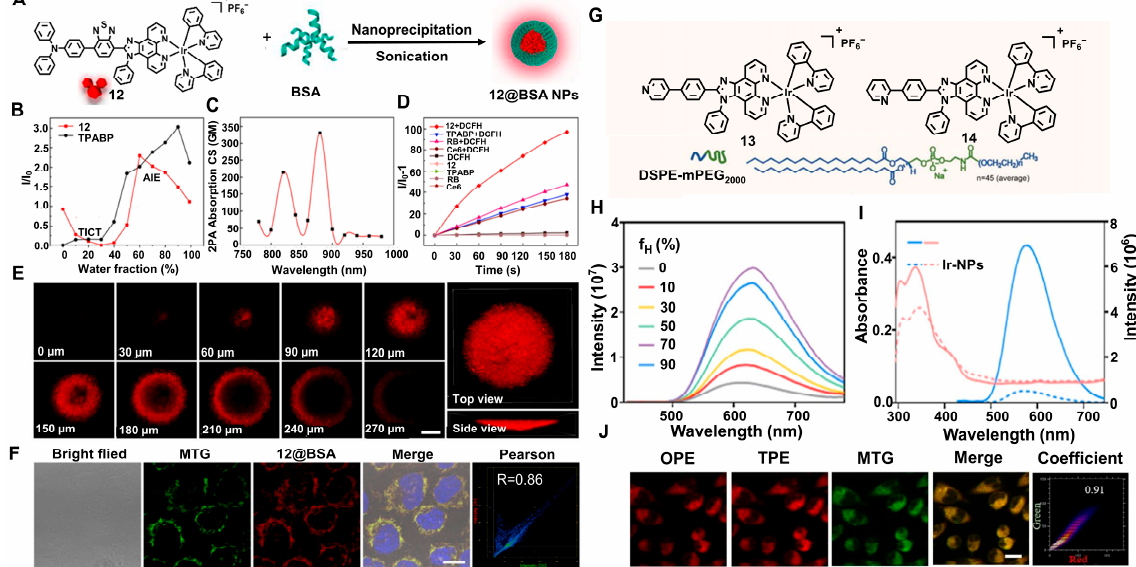
Figure 6. ( A ) Schematic illustration of the fabrication of 12@BSA NPs . ( B ) Plots of the relative emission intensity (I/I 0 ) versus water fraction. ( C ) Two-photon absorption cross-section of 12@BSA NPs . ( D ) ROS detection in the presence of samples under laser illumination. ( E ) Two-photon images of 3D tumor cells incubated with 12@BSA NPs . ( F ) Confocal images of MCF-7 cells after co-culture with 12@BSA NPs . Reprinted with permission from [62], copyright 2022, Elsevier. ( G ) Chemical structures of 13 and 14 . ( H ) Phosphorescence spectra of 13 in H 2 O/DMSO mixtures. ( I ) The absorption and PL spectra of 13 and 13 NPs . ( J ) The one-photon excitation (OPE)/two-photon excitation (TPE) confocal images of 13 NPs . Reprinted with permission from [63], copyright 2021, Springer Nature.